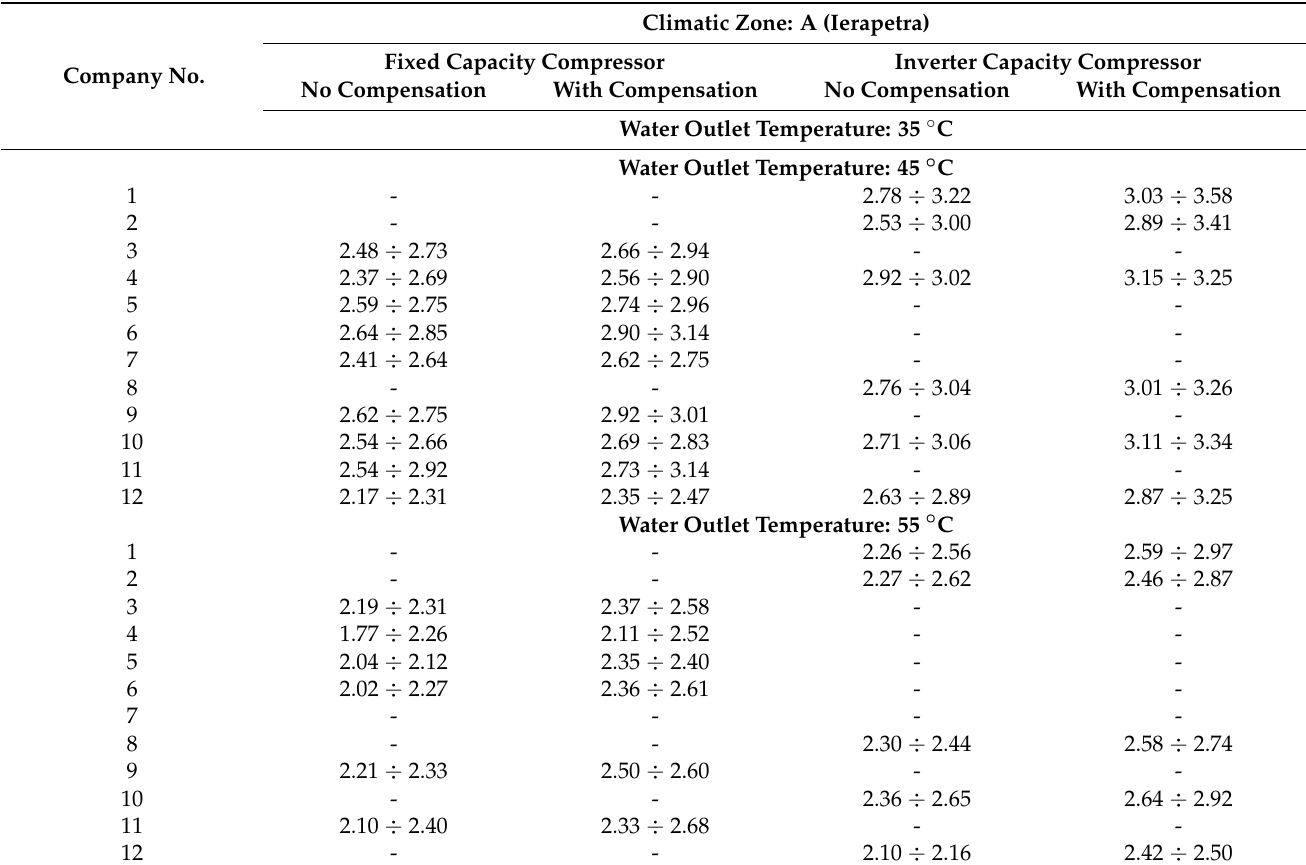
Table 5. AWHPs’ SCOP per company: Athens, water outlet temperature 35, 45, and 55 ◦ C.